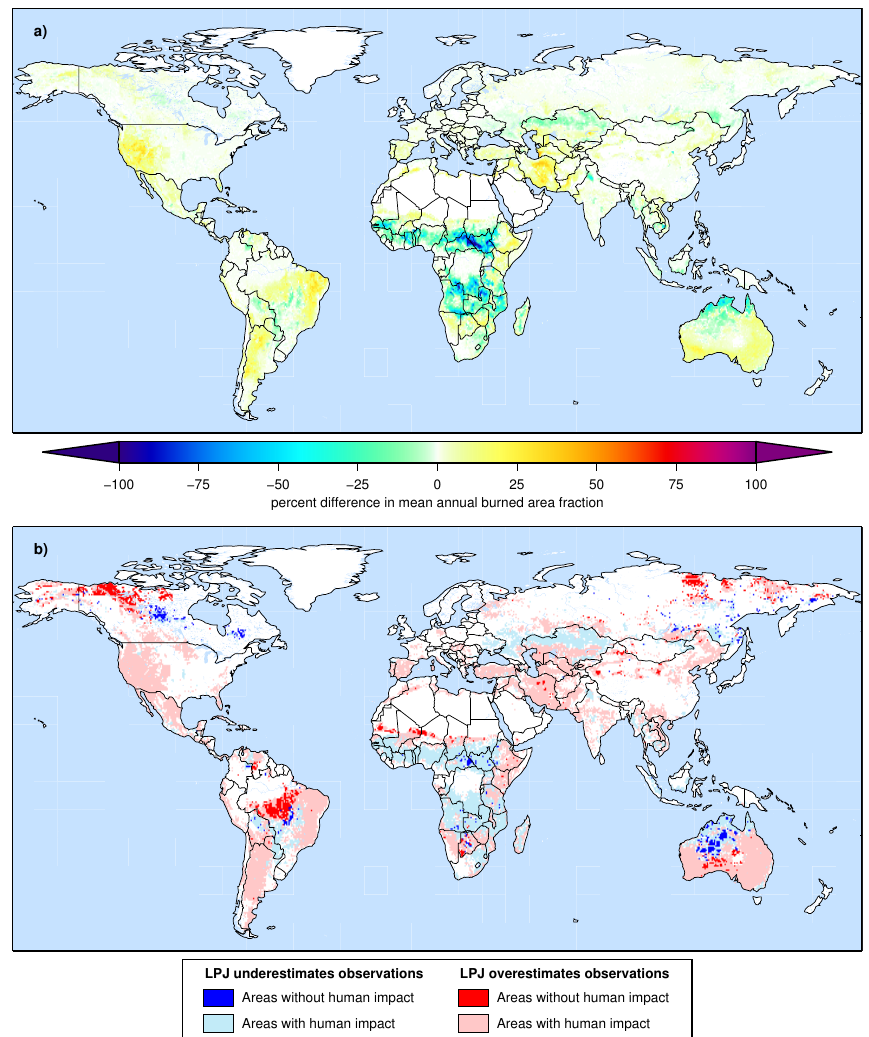
Fig. 12. (a) Residuals between observed average annual area burned in GFED and simulated burned area. (b) Residuals between observed and simulated annual area burned in context of anthropogenic imprint on the global land